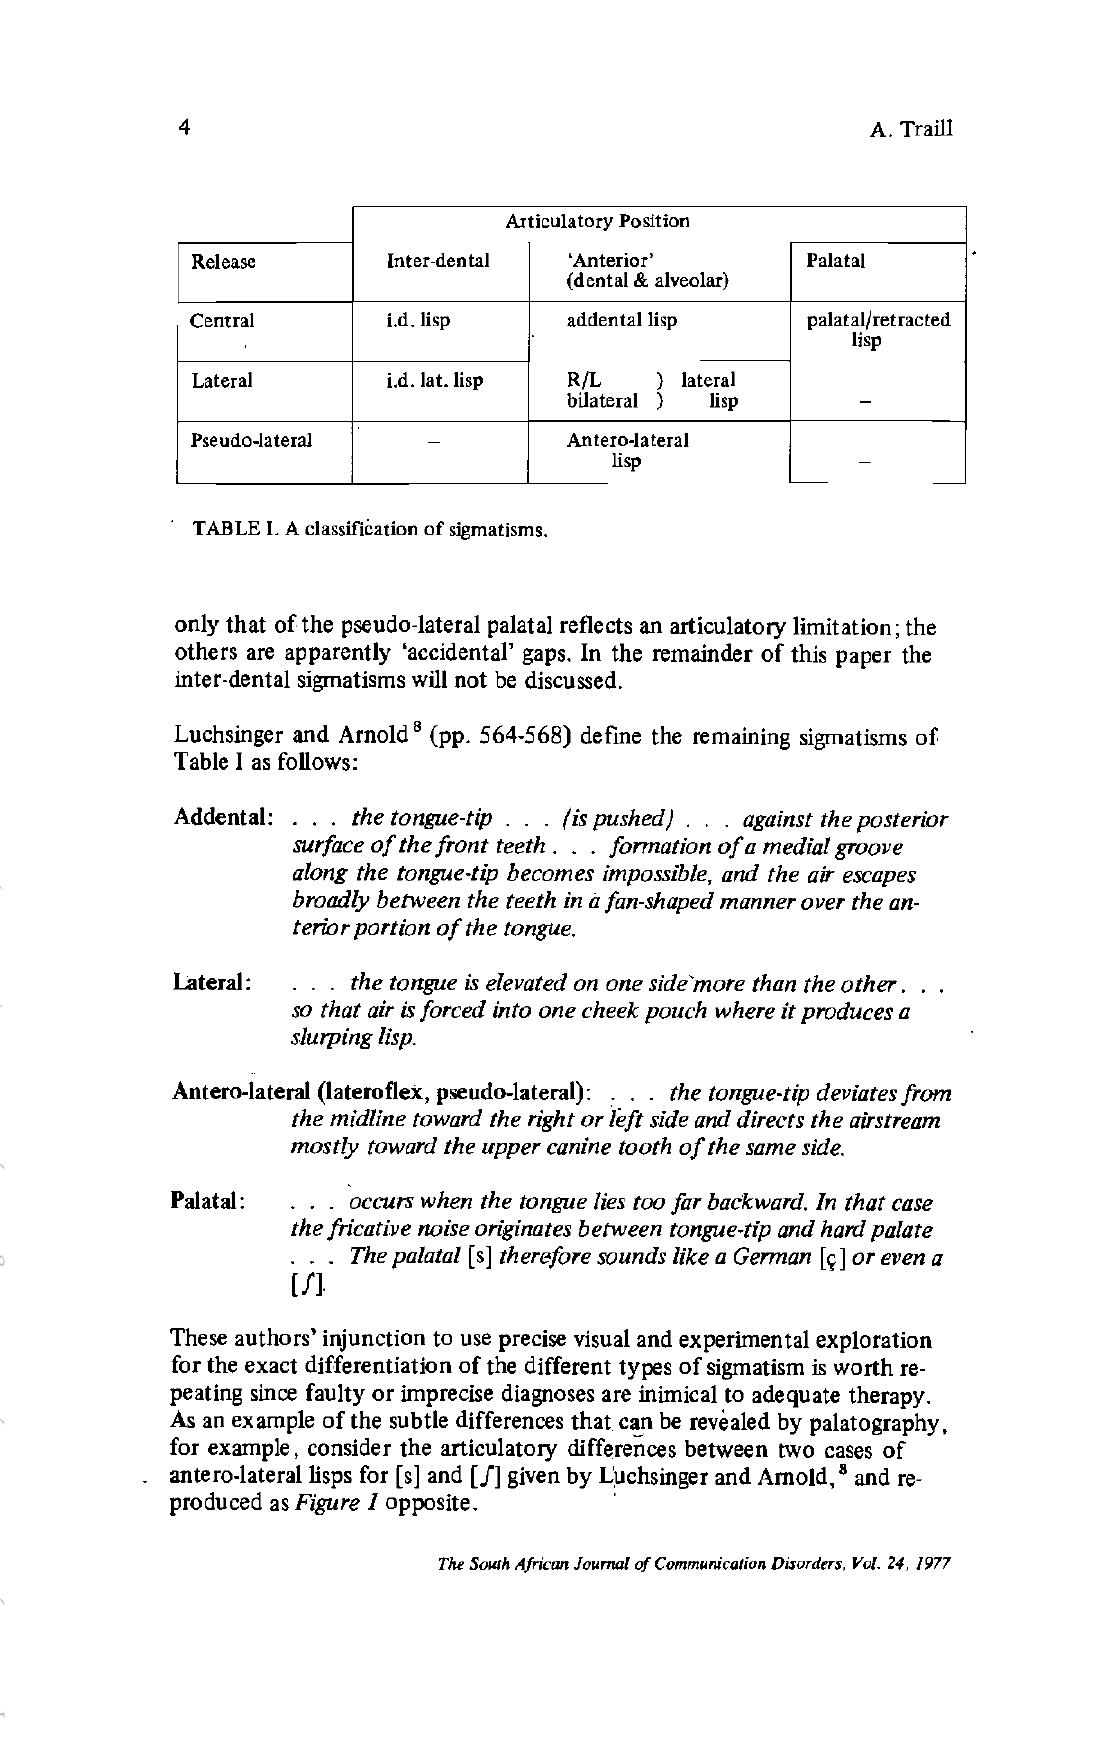
TABLE I. A classification of